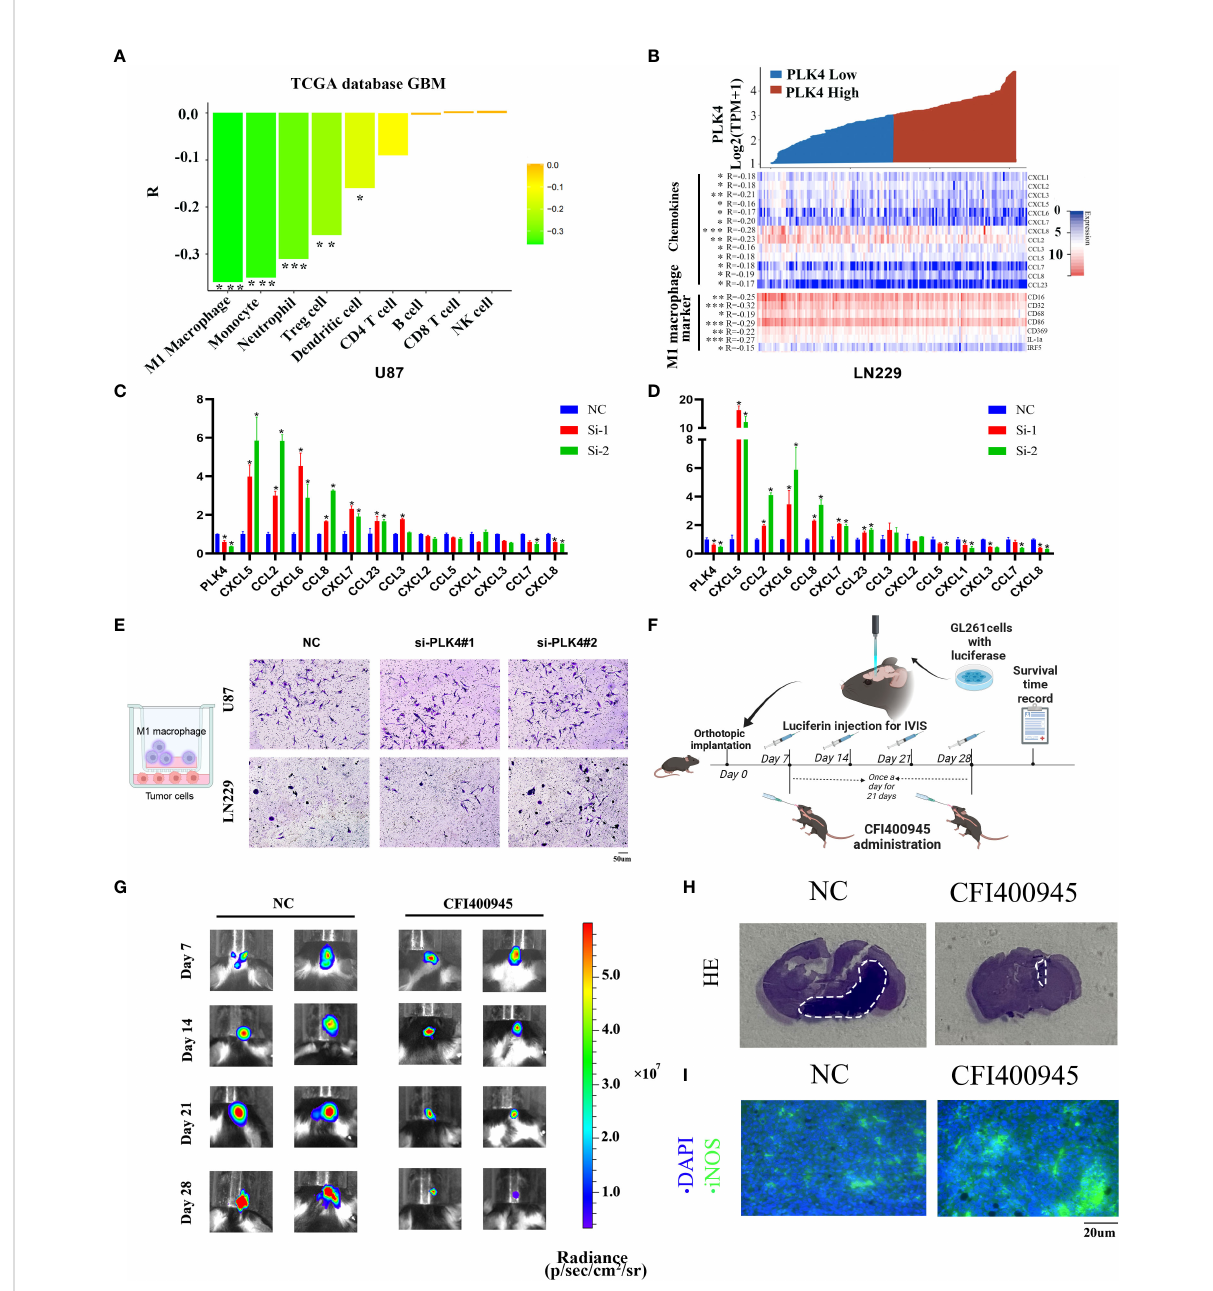
FIGURE 8 PLK4 is correlated with M1 macrophage in fi ltration in glioma. (A) Analysis of immune cell in fi ltration and PLK4 expression in TCGA-GBM data sets by quanTIseq algorithm. * P <0.05, ** P < 0.01, *** P < 0.001. (B) The relationship between PLK4 mRNA expression and M1 macrophage- related chemokines/markers in GBM. * P <0.05, ** P < 0.01, *** P < 0.001 (C, D) The expression levels of several M1 macrophage-related chemokines after knockdown of PLK4 in U87 and LN229 cells. * P < 0.05. (E) In fi ltration of M1 macrophages in NC (left), si-PLK4#1 (middle), si- PLK4#2 (right) of U87 and LN229 cells. (F) Schematic illustration of the experimental design for orthotopic model construction. (G) Imagining of GBM tumor-bearing mice and corresponding quanti fi cation of ROI signal of the tumor site at 7, 14, 21 and 28 days. (H) HE staining showed decreased tumor volume in mice with CFI400945 administration. (I) Immuno fl uorescence staining showed M1 macrophages in fi ltration of tumor region in